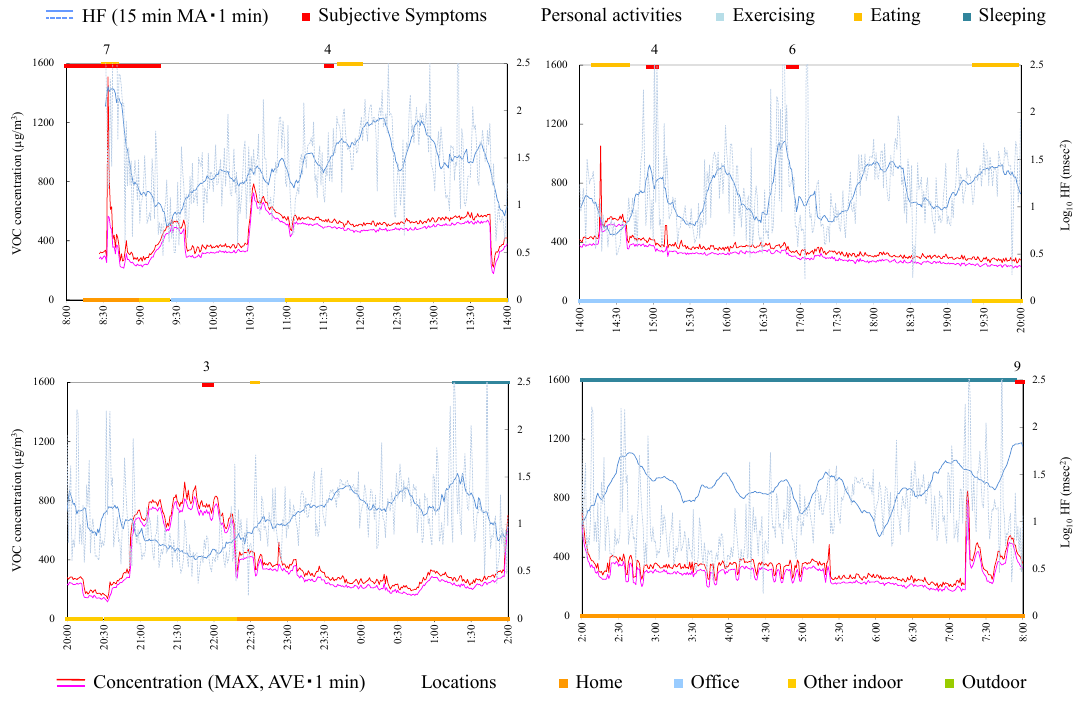
Figure 10. Time-series data of VOC concentration and log 10 HF (subject H). Subjective symptoms and personal activities are indicated in upper side and locations are indicated in lower side. The values on subjective symptoms are symptom